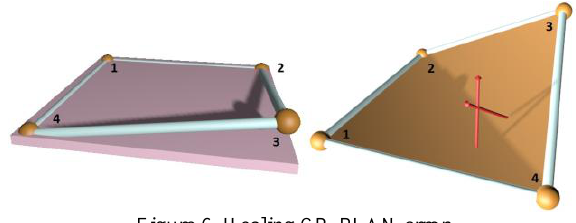
Figure 6. Healing CP_PLAN error